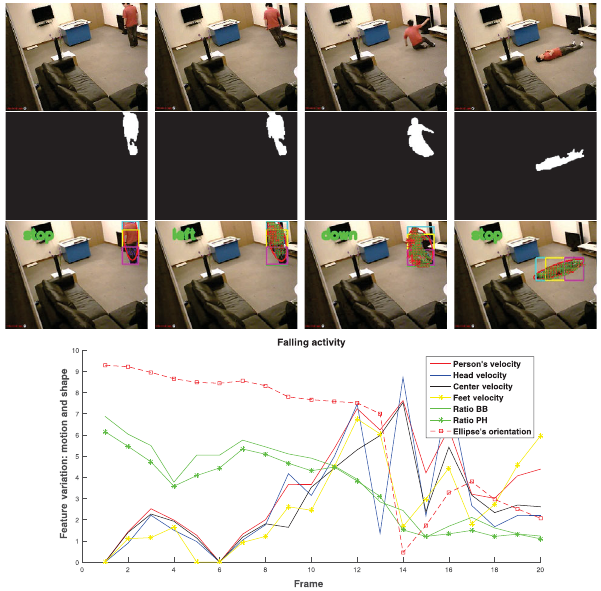
Fig. 14 Falling activity. Row 1: input frames. Row 2: extracted human silhouettes. Row 3: three blocks representation. Graph: variation in feature values over 20